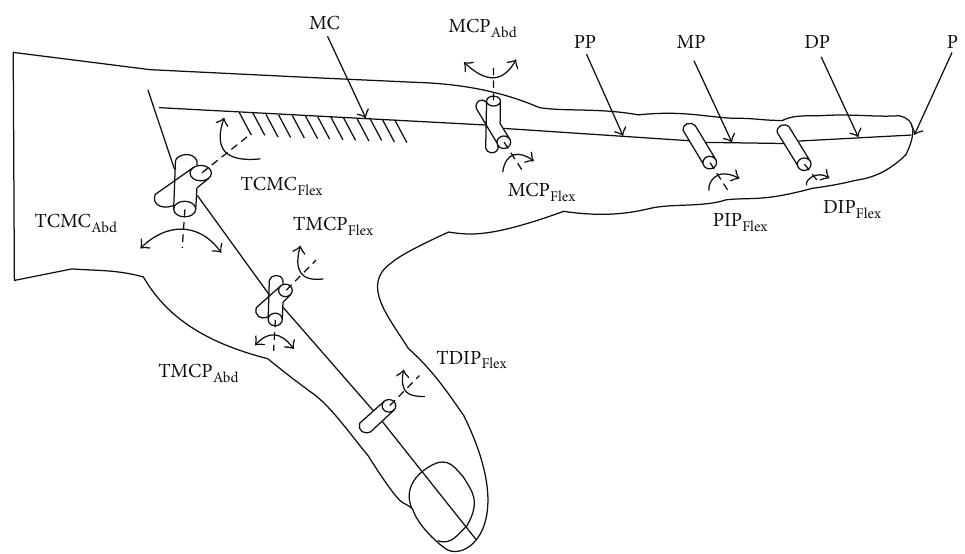
Figure 1: Kinematic model of hand with fixed metacarpal (except thumb).